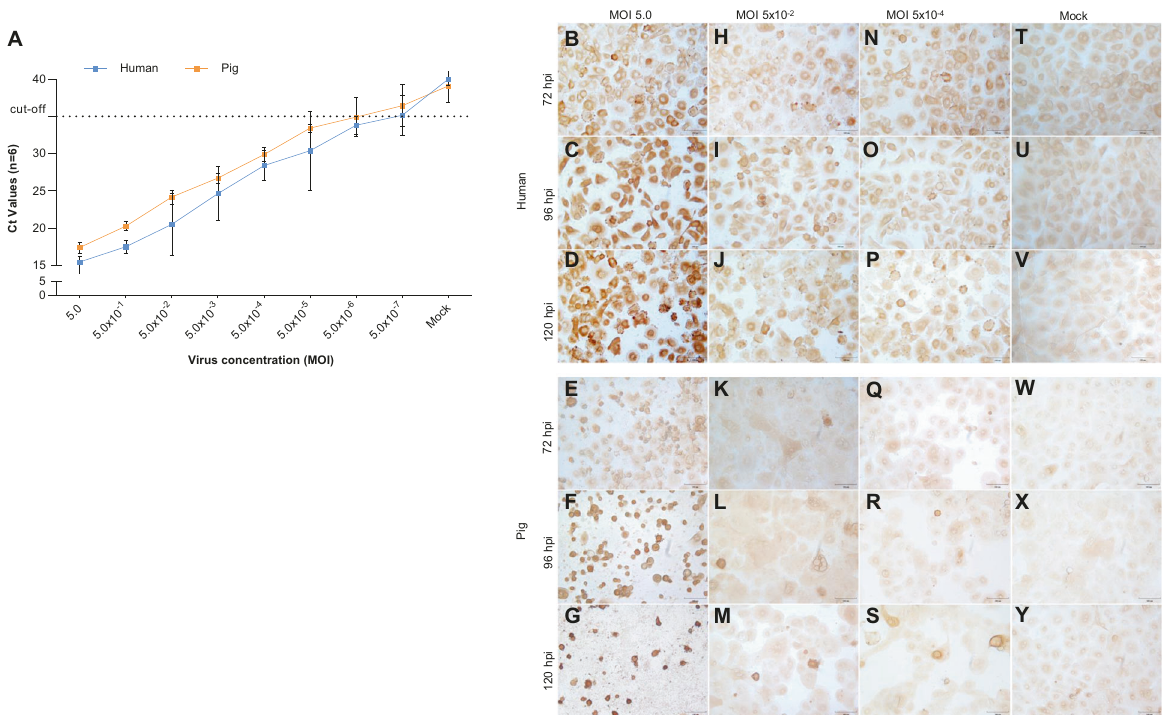
Fig. 3 Dose-dependent infectious response of SARS-CoV-2 in HRECs and PRECs. A Detection of SARS-CoV-2 viral nucleocapsid (N) gene using EZ ™ -SARS-CoV-2 Real-Time RT-PCR developed by Tetracore. A volume of 7 μ L Trizol extracted viral RNA sample was used in each reaction, and all RT-qPCR reactions were set up by including negative, positive, and no-template controls (NTC). Data from 6 technical replicates at each infection dose. Blue — HRECs (Human), Orange — PRECs (Pigs) ( n = 6). A Line graphs (Mean; SD) plotted using RT-qPCR Ct values obtained from the supernatants of HRECs and PRECs inoculated with various doses of SARS-CoV-2 (Isolate USA-WA1/2020) for 120 h. B – Y Cells fi xed in 4% paraformaldehyde were stained for SARS-CoV-2 viral N protein with ImmPRESS VR anti-rabbit IgG horseradish peroxidase (HRP) polymer detection kit (MP-6401-15; Vector Laboratories) and a recombinant anti-SARS-CoV-2 N protein rabbit monoclonal antibody (0.75 μ g/mL) [The following reagent was obtained through BEI Resources, NIAID, NIH: Monoclonal Anti-SARS Coronavirus/SARS-Related Coronavirus 2 Nucleocapsid Protein (produced in vitro), NR-53791; SinoBio Cat: 40143-R001]. Dark brown represents a positive expression of the antibody, and pale brown represents background staining. HRECs inoculated with SARS-CoV-2 at three different infectious doses, i.e., MOI 5.0 ( B – D ), 5.0 × 10 − 2 ( H – J ), 5.0 × 10 − 4 ( N – P ) and mock ( T – V ), and three different time points [( B , H , N , T ) 72 hpi; ( C , I , O , U ) 96 hpi; ( D , J , P , V ) 120 hpi]. Similarly, PRECs inoculated with SARS-CoV-2 at E – G MOI 5.0, K – M 5.0 × 10 − 2 , Q – S 5.0 × 10 − 4 , and W – Y mock-inoculated with culture medium, as well as three different time points [ E , K , Q , W 72 hpi; F , L , R , X 96 hpi; G , M , S , Y 120 hpi]. Scale bar — 100 μ